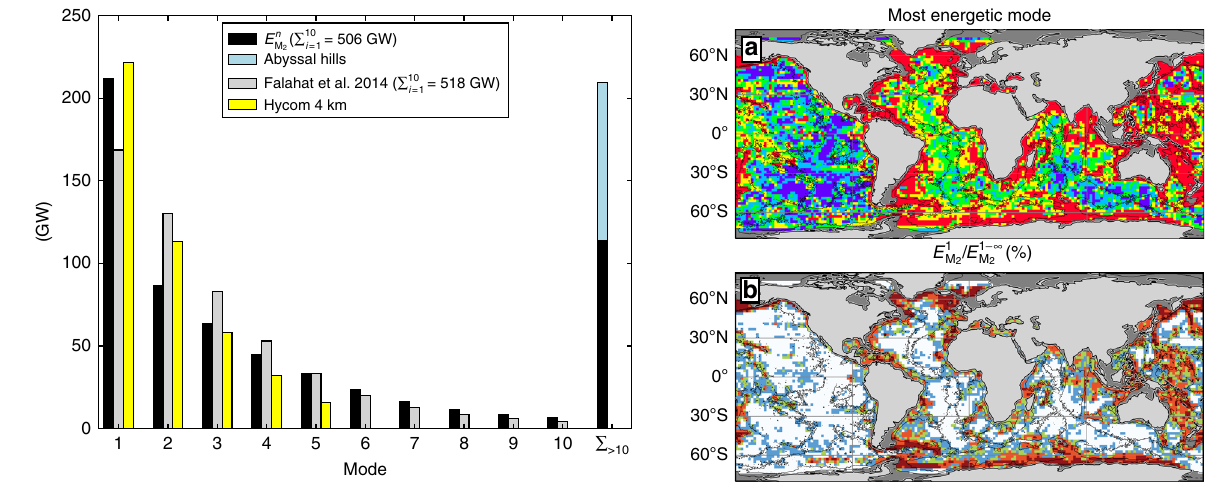
currents (TPXO8 vs. TPXO6.2). Our estimate for modes 1 – 5 also